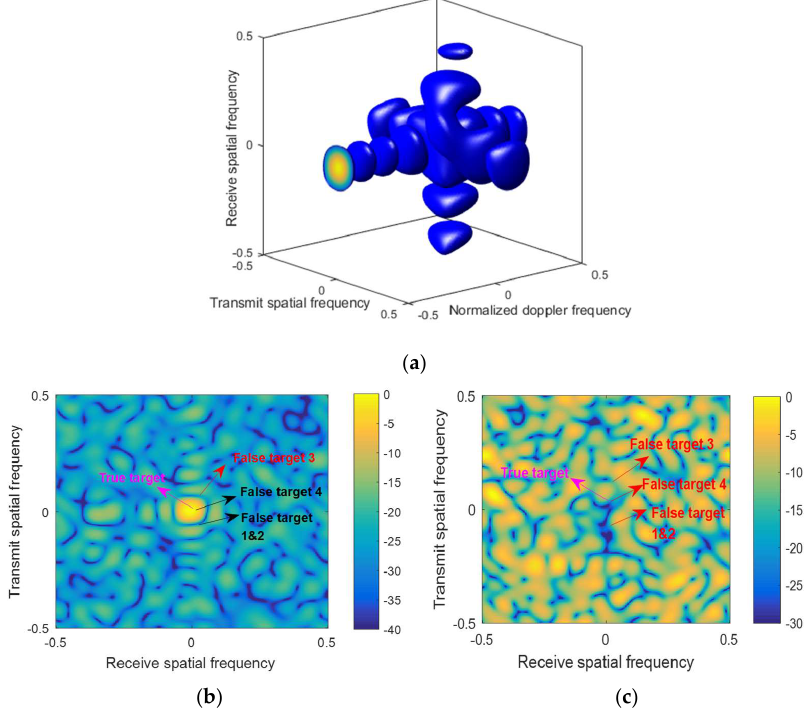
Figure 7. Beampatterns. ( a ) Transmit-receive-Doppler 3D beampattern of the QPC-FDA-MIMO radar. ( b ) Transmit-receive slice of the 3D beampattern of the QPC-FDA-MIMO radar. ( c ) Transmit-receive beampattern of the FDA-MIMO radar.